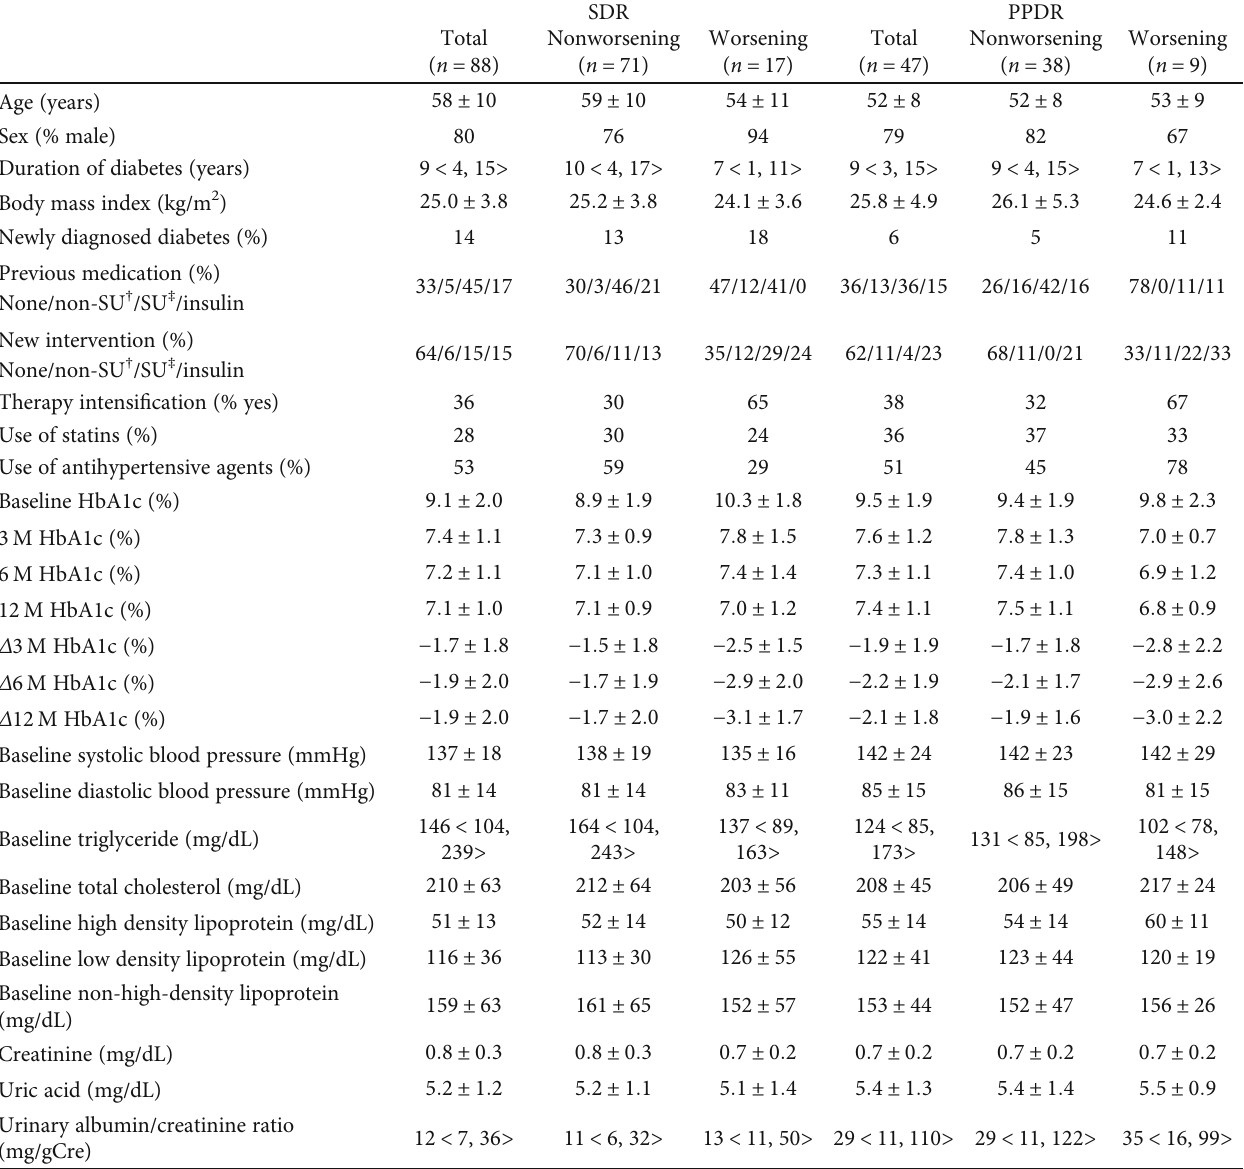
Table 1: Summary of the clinical characteristics of patients with simple and preproliferative diabetic retinopathy.